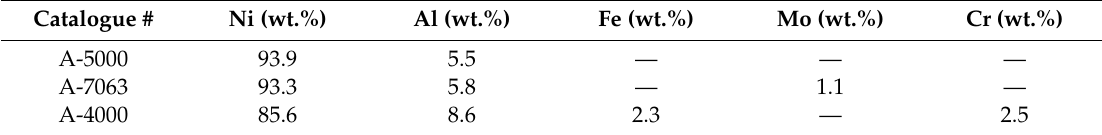
Table 1. Chemical composition of Raney nickel catalyst used in this